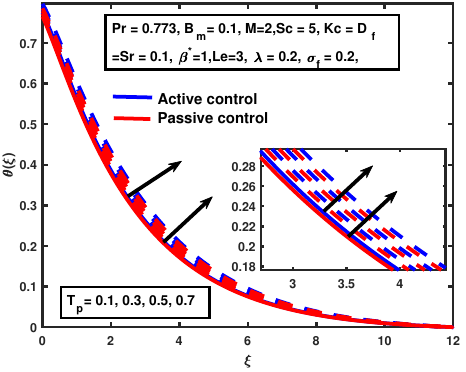
Figure 5. The impact of θ ( ξ ) on thermophoresis T p .